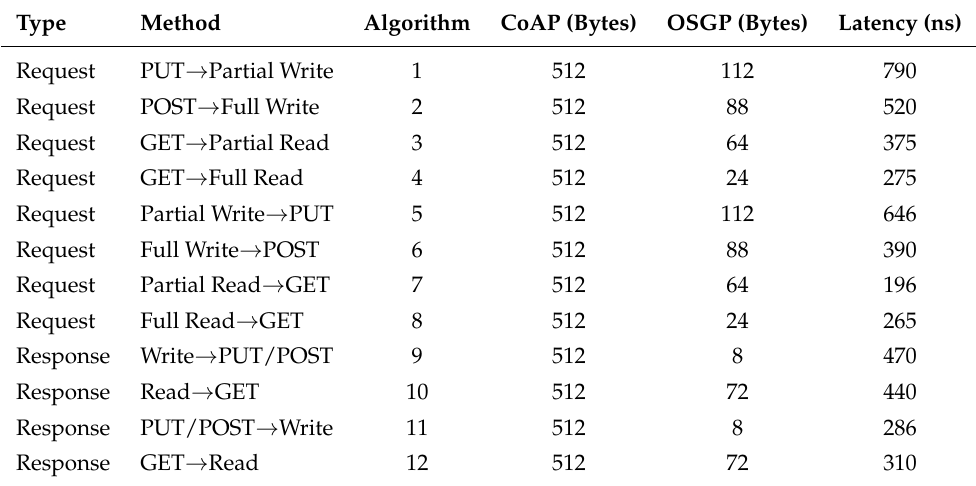
Table 2. Packets size and latency of mapping methods running on the PC-based